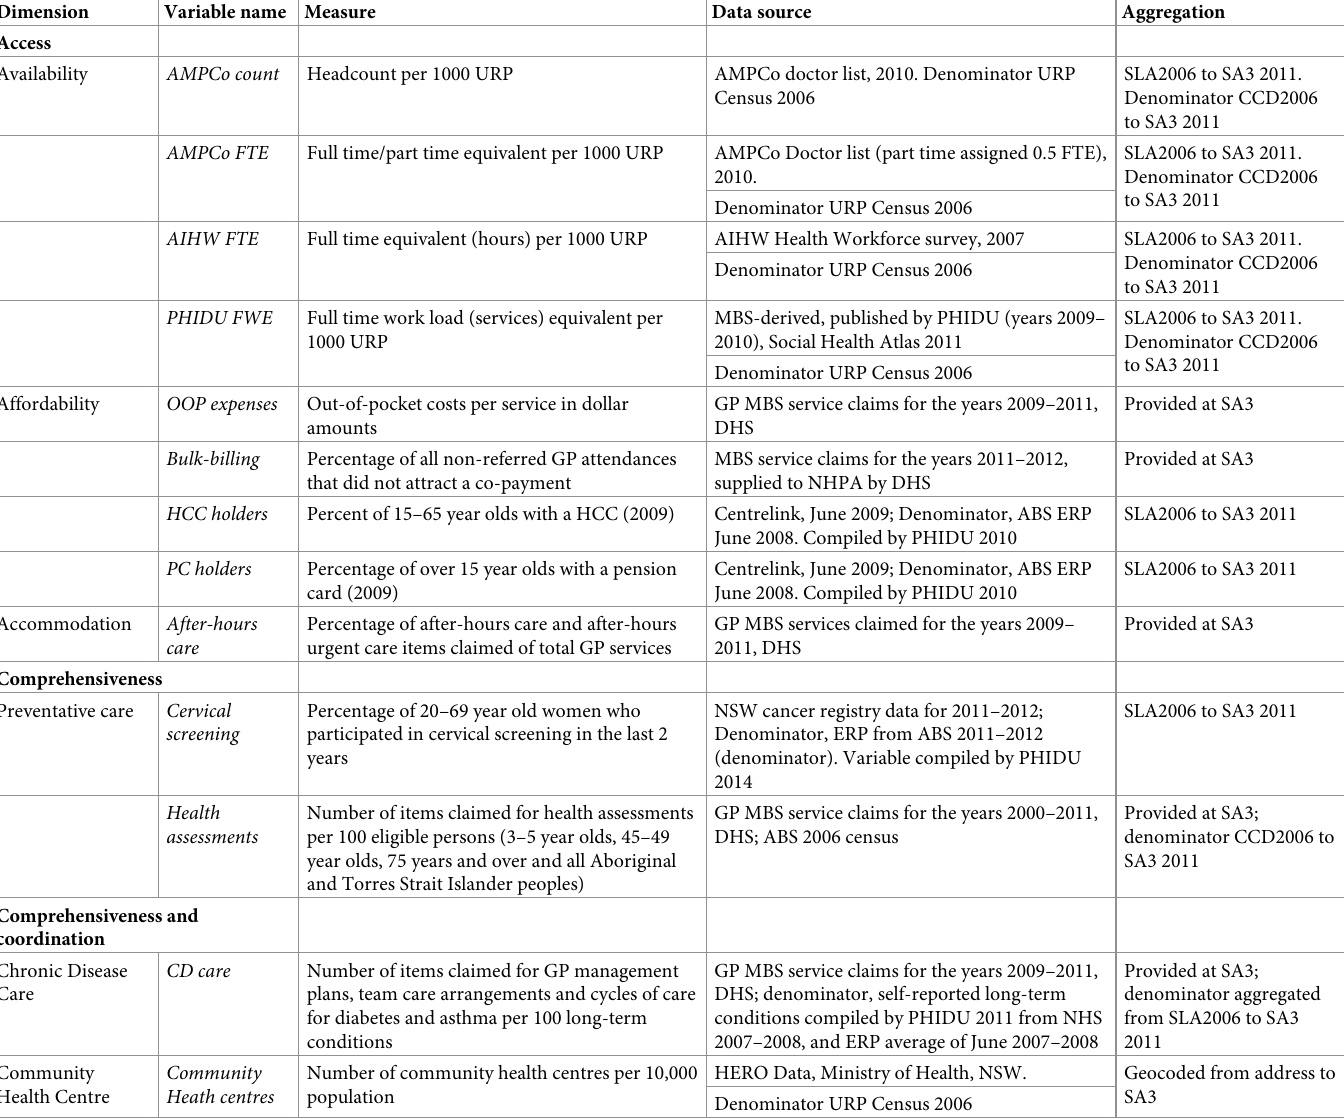
Table 1. Area-level PHC service characteristic measures, data sources and geographical